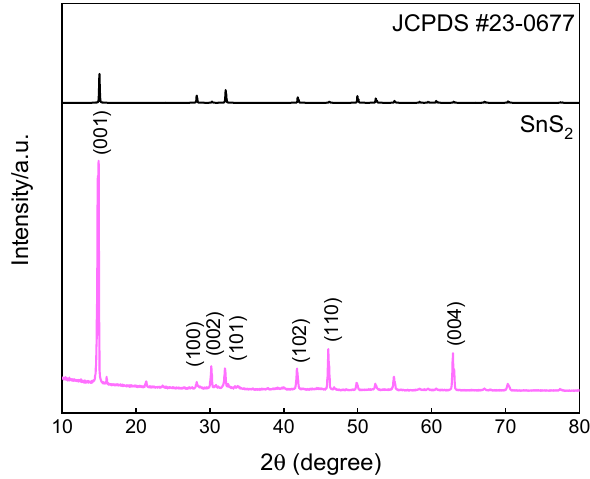
Figure 1. XRD patterns of nanometer SnS 2 .